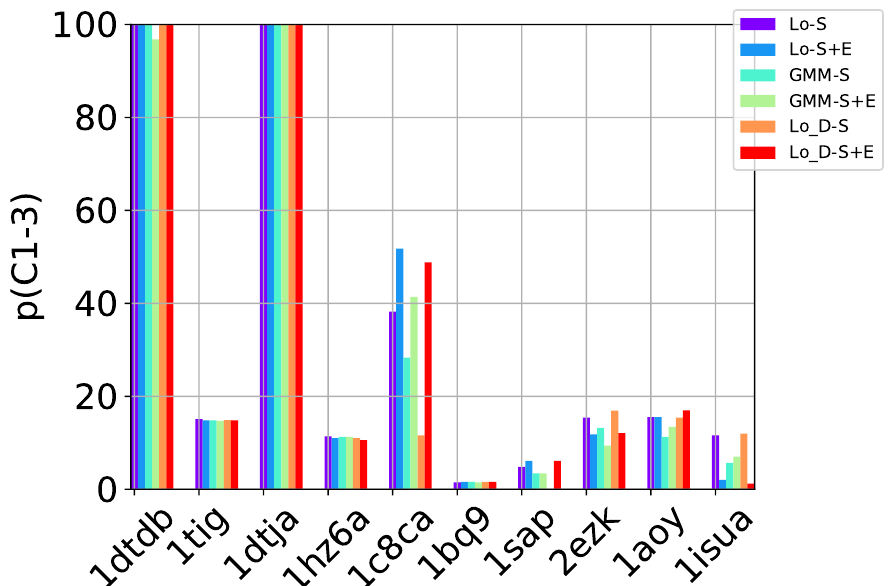
Figure 4. Comparison of community detection methods based on the quality of the top three communities selected by Sel-S and Sel-S+E. In the legend, Lo-D refers to the Louvain method applied to directed nngraphs that embed the decoy datasets. The -S and -S+E refer to the Sel-S and Sel-S+E selection strategies.